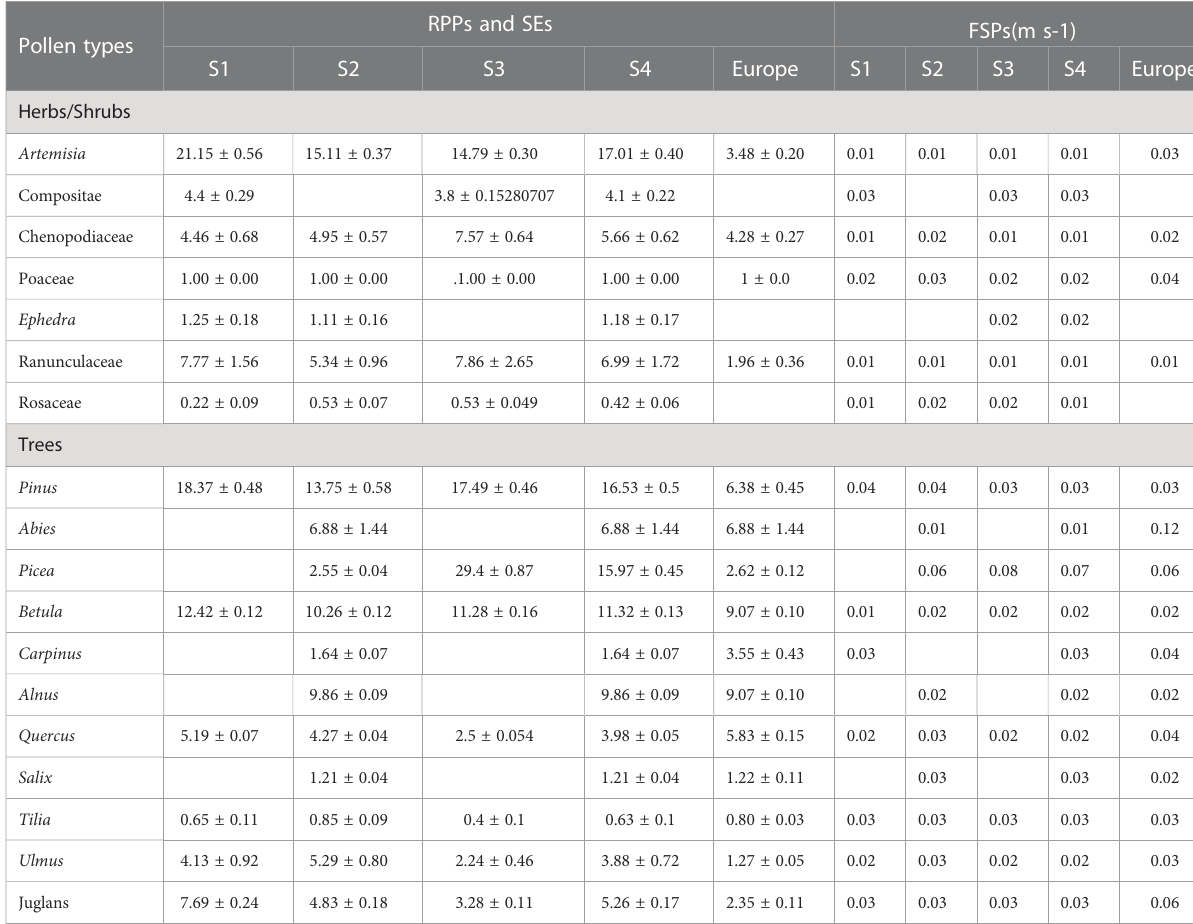
TABLE 3 Relative pollen productivity estimates (RPPs) with their standard errors (SEs) and fall speeds of pollen (FSPs) for the 18 pollen types that were used in this study.